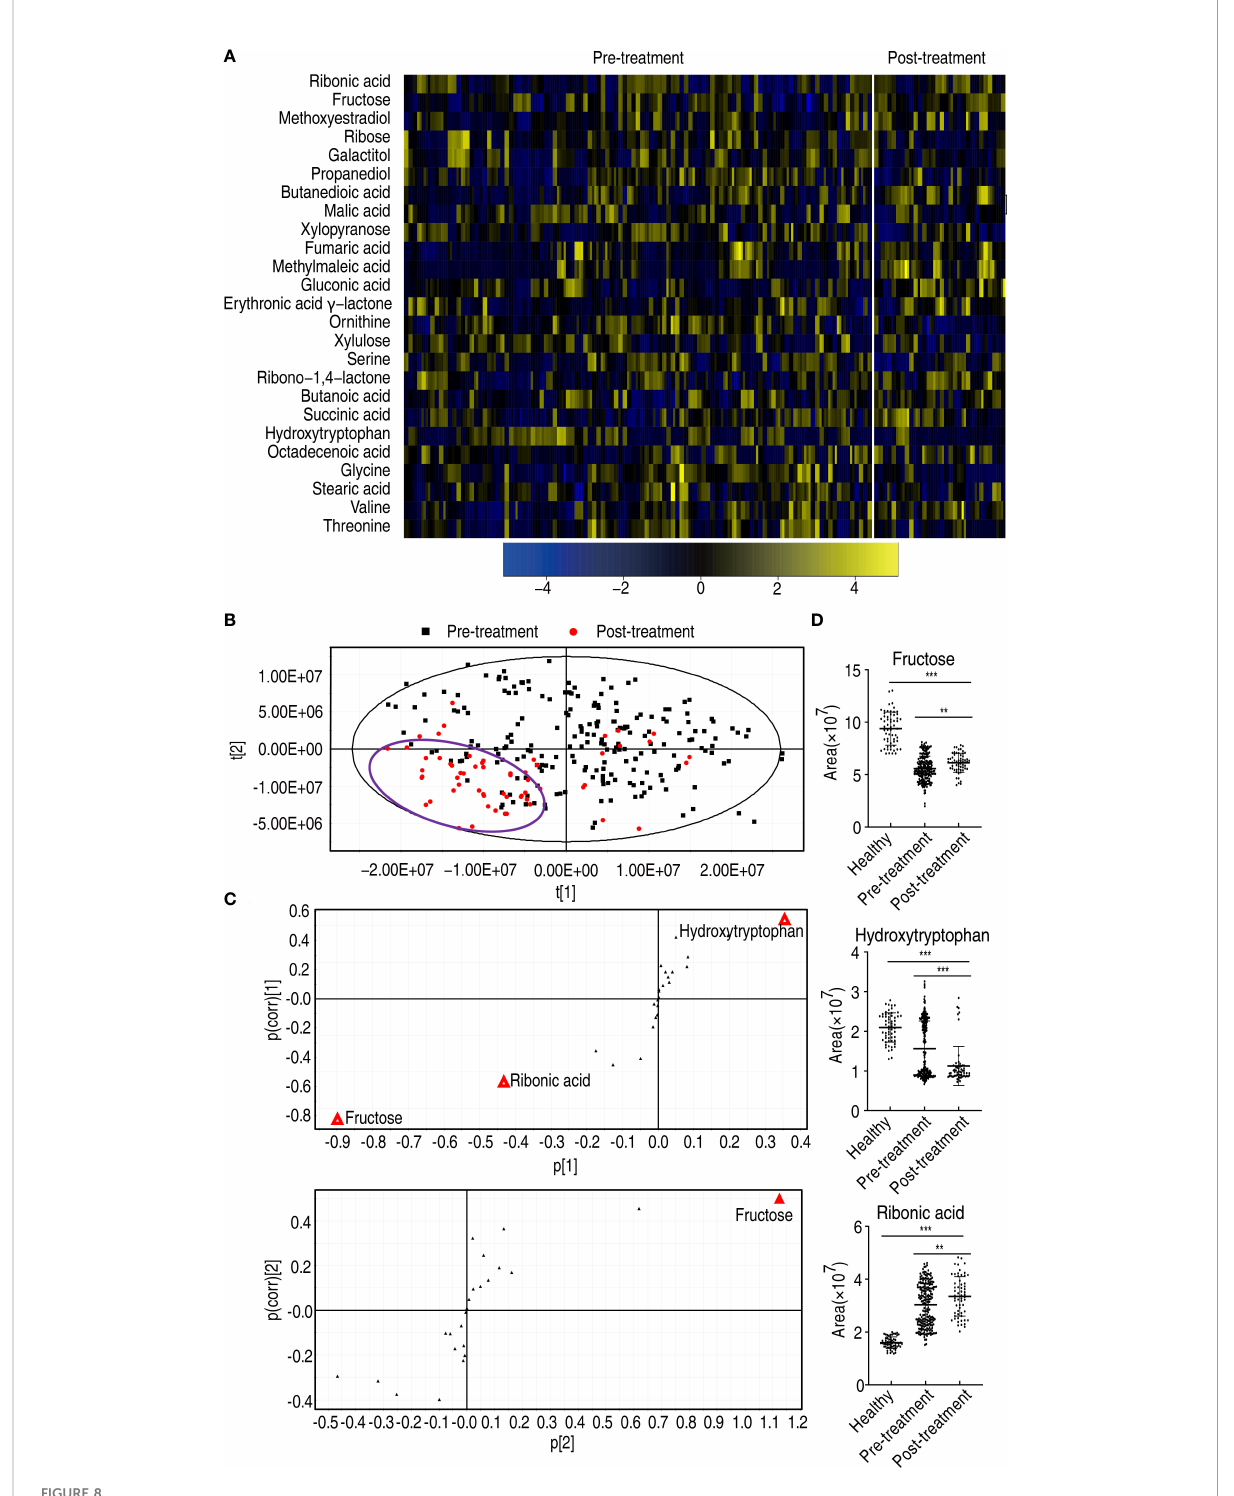
FIGURE 8 Differential metabolomes and biomarker identi fi cation between patients who received treatment and patients who did not receive treatment. (A) Heatmap showing differential metabolites. (B) PLS-DA of esophageal cancer before and after treatment. (C) S-plot is generated from PLS-DA. The triangle represents metabolites and candidate biomarkers are highlighted in red. (D) Abundance of biomarkers. Results are displayed as mean ± SEM, ** p < 0.01, and *** p < 0.001 as determined by Student ’ s t